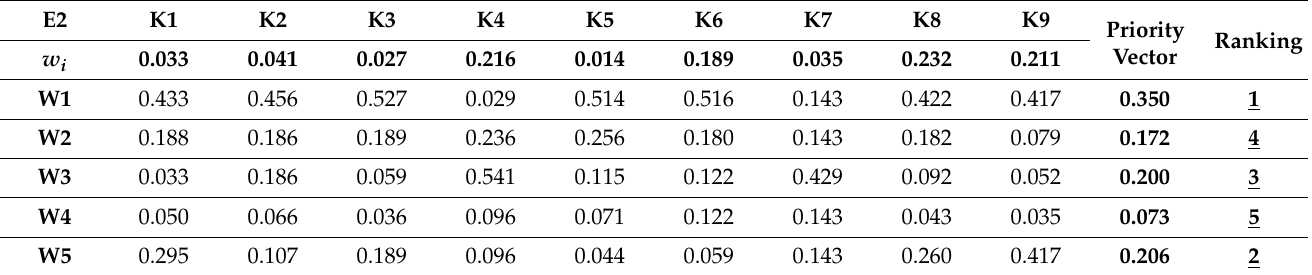
Table 4. Ranked list of the final weight distributions of the respective equipment variants according to Expert 2.